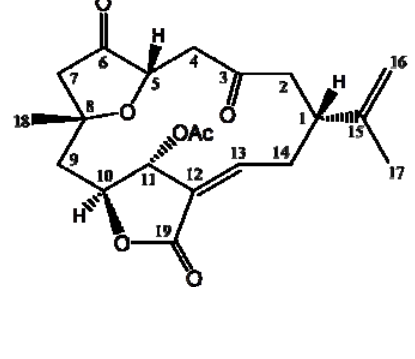
Figure 1. Chemical structure of 5-episinuleptolide acetate (5EPA), a norcembranoidal diterpene isolated from the Formosan soft coral Sinularia sp